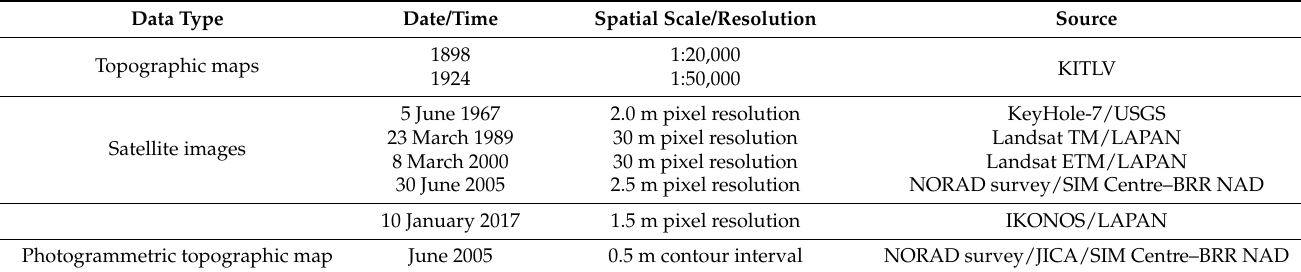
Table 1. Spatial data sources for shoreline change